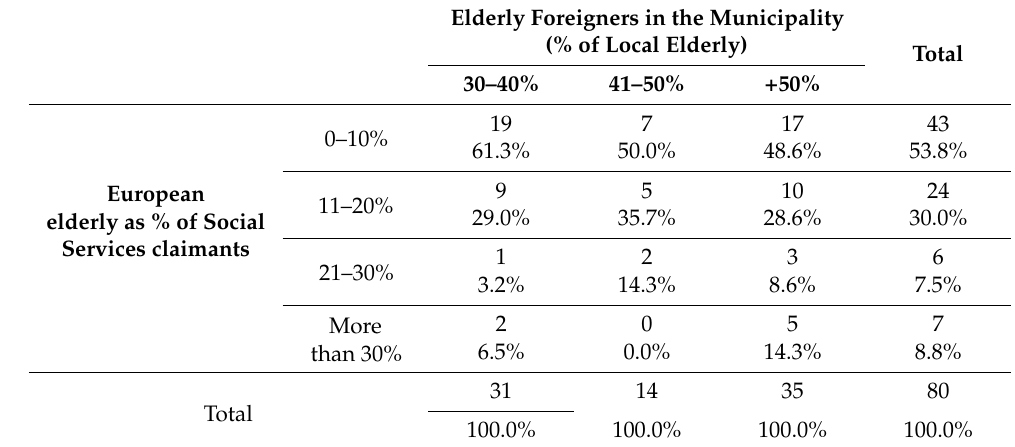
Figure 3. Share of foreigners among the elderly and share of retirement migrants among users of local Social Services. Source: Own elaboration with primary data from our telephonic survey with Social Services’ coordinators and data from Local Registers. Each dot is a municipality. In the hori- zontal axis one can see the share of foreigners among elderly residents in each municipality; In the vertical axis one can see the share of European elderly (non-Spaniards) among claimants of Sociale Services. The line is the regression line for a linear regression model with the two variables. Table 3. European elderly among user of Social Services and share of foreigners in the municipality (% of local elderly).